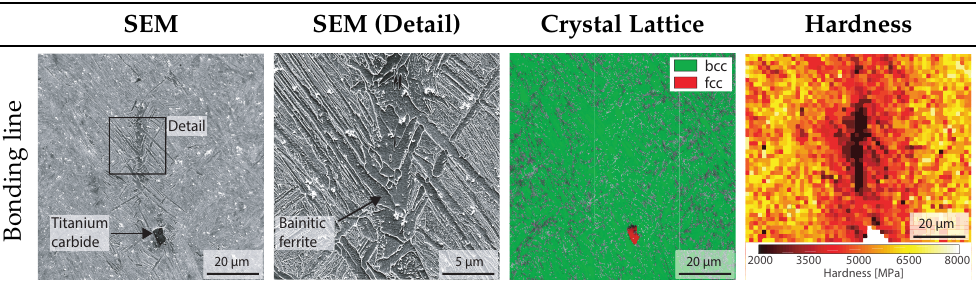
Table 4. Investigation of the bonding line with SEM, EBSD for differentiation between body-centered cubic (bcc) and face-centered cubic (fcc) phase and nanohardness measurements.